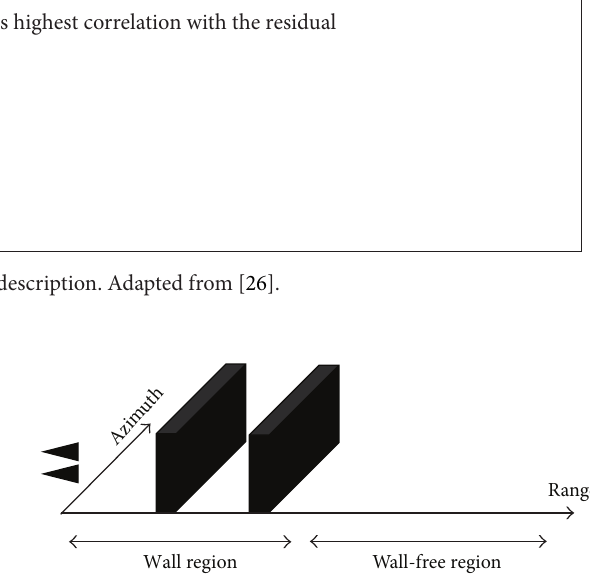
Figure 8: Two regions are described and will be treated differently. Walls may appear closer to the sensor. Further away only point targets are